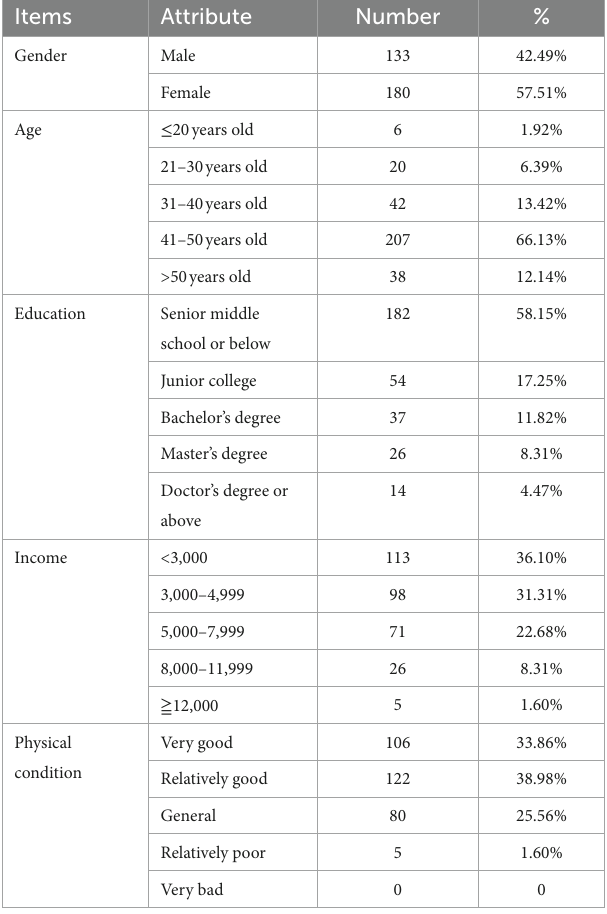
TABLE 2 Descriptive statistics of interviewees’ characteristics.